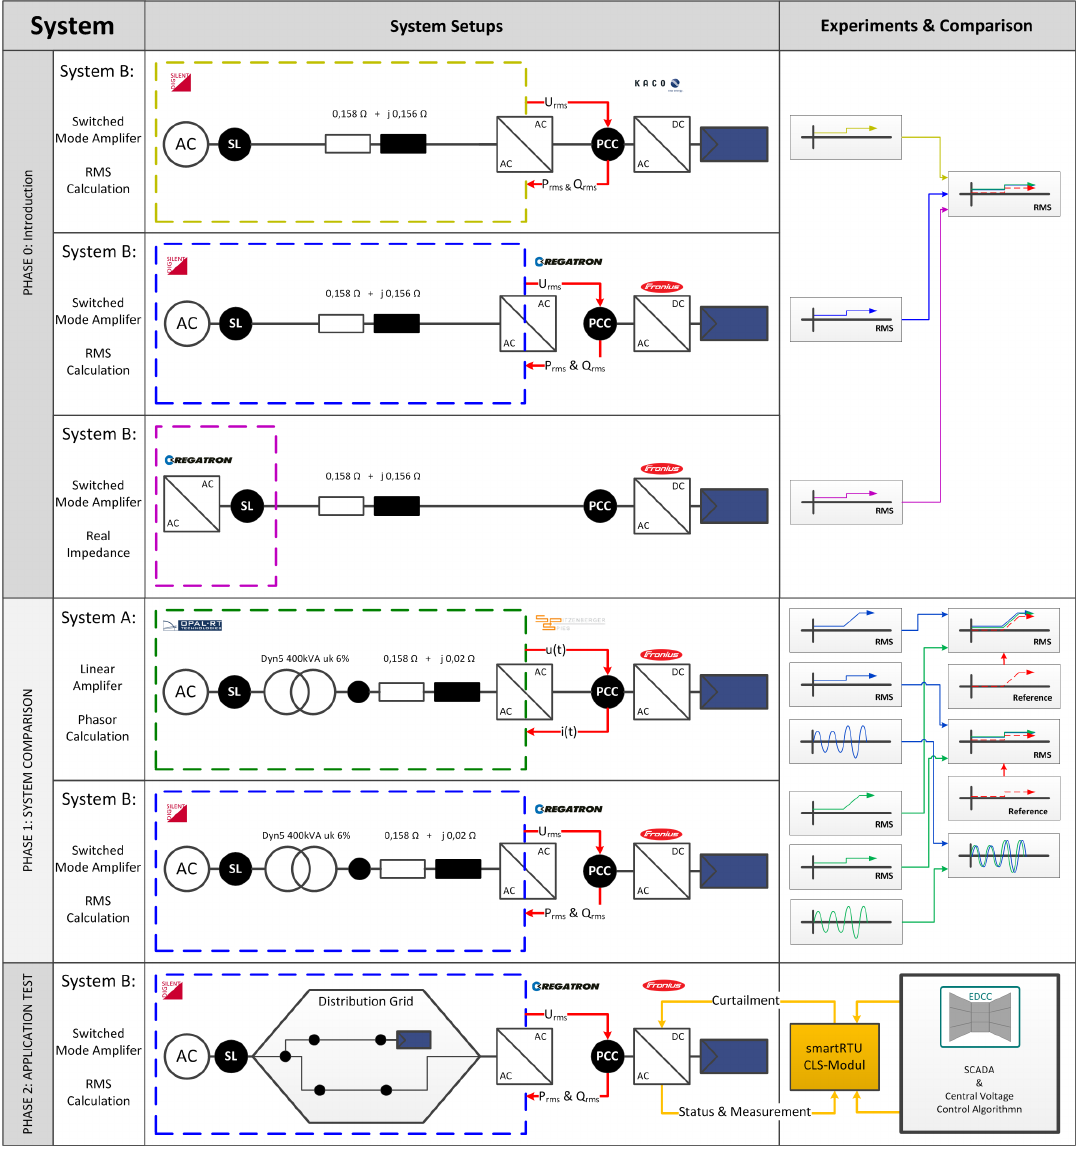
Figure 6. Schematic overview of the test scenarios for the comparison of the system response, which is split into three phases. The system setups and the implemented grid models as well as the individual experiments and the carried comparisons are shown. The colour of dashed box corresponds with with the graphs in the following